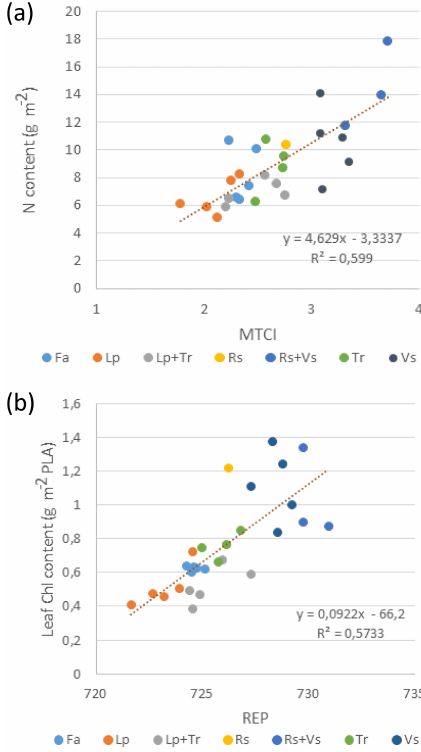
Figure 5. (a) Relation between field-measured nitrogen content and index MTCI of A. sativa in response to plant legacy treatments – Fa: fallow; Lp: Lolium perenne ; Rs: Raphanus sativus ; Tr: Trifolium repens ; Vs: Vicia sativa . (b) Relation between field-measured leaf chlorophyll content and red edge position index of A. sativa in re- sponse to plant legacy treatments – Fa: fallow; Lp: Lolium perenne ; Rs: Raphanus sativus ; Tr: Trifolium repens ; Vs: Vicia sativa